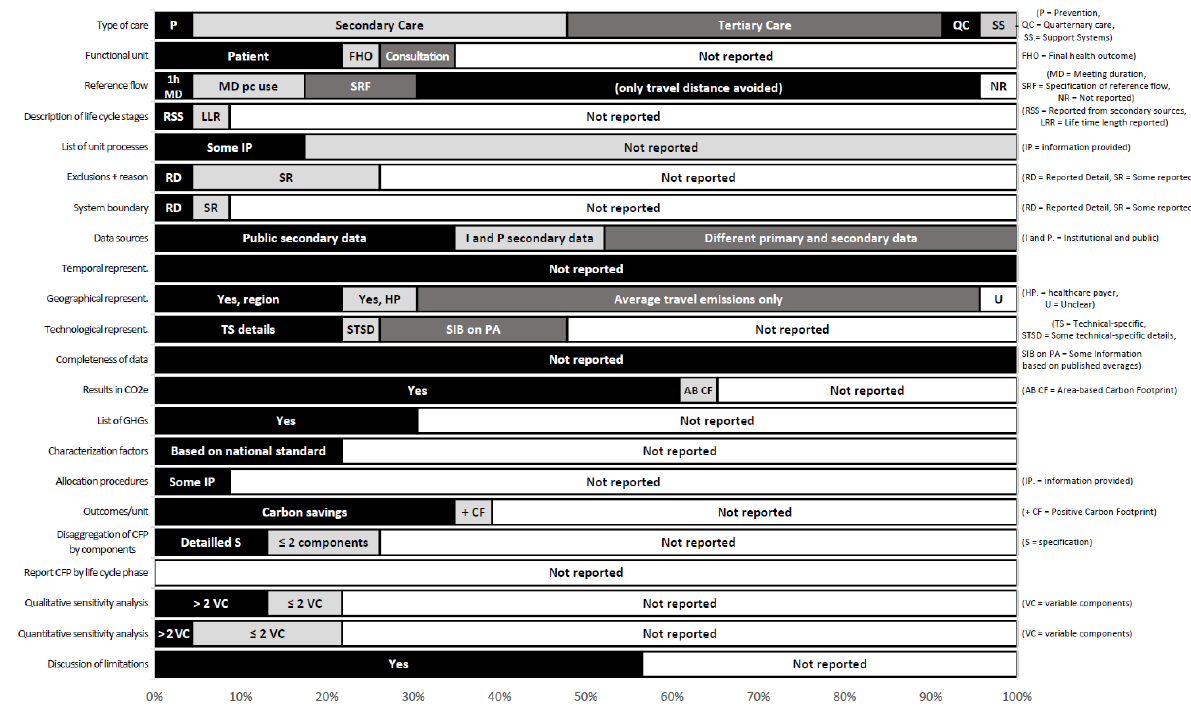
Figure 3. Overview of study results reported by